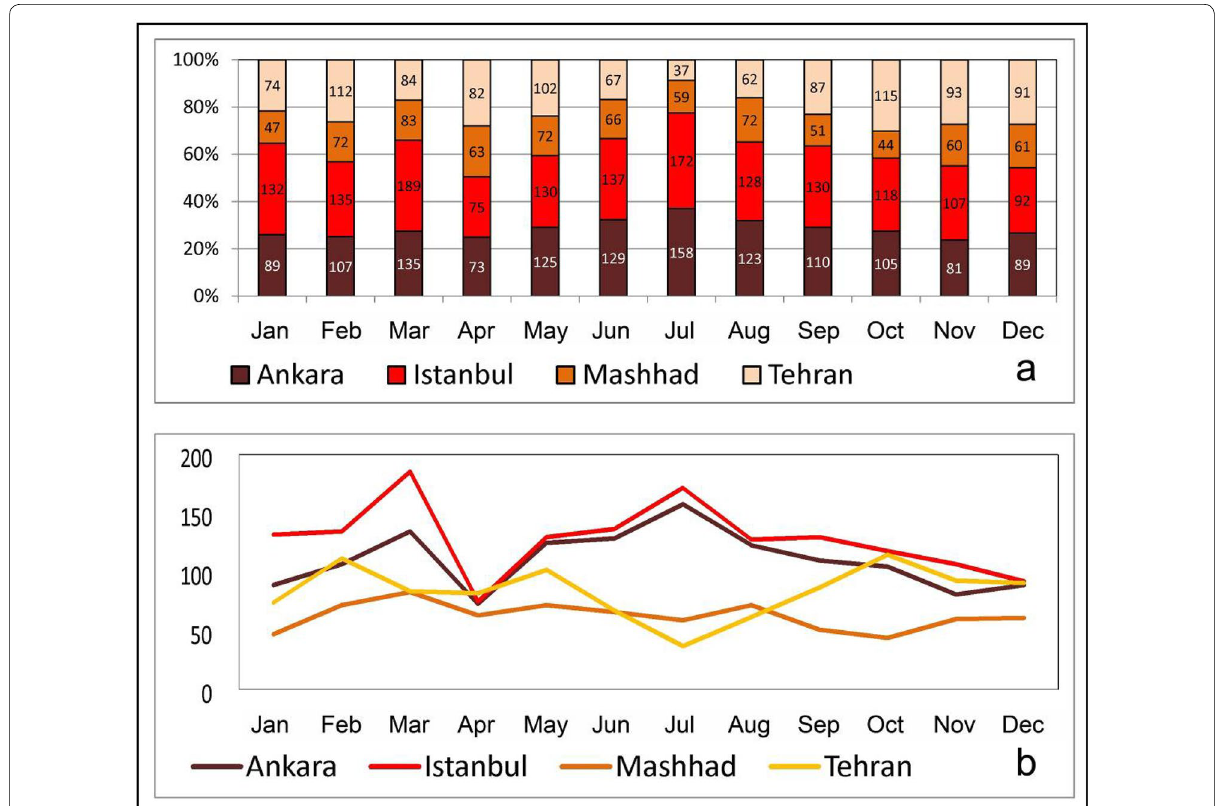
Fig. 6 Monthly scaled mean SWEAT data for a the percentile contribution of data to each study area and b linear variation of data for the study